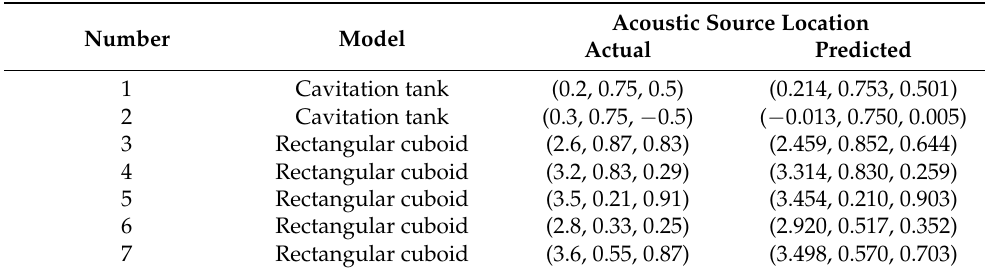
Table 1. Prediction results obtained by combining the data of the rectangular cuboid model and large cavitation tank